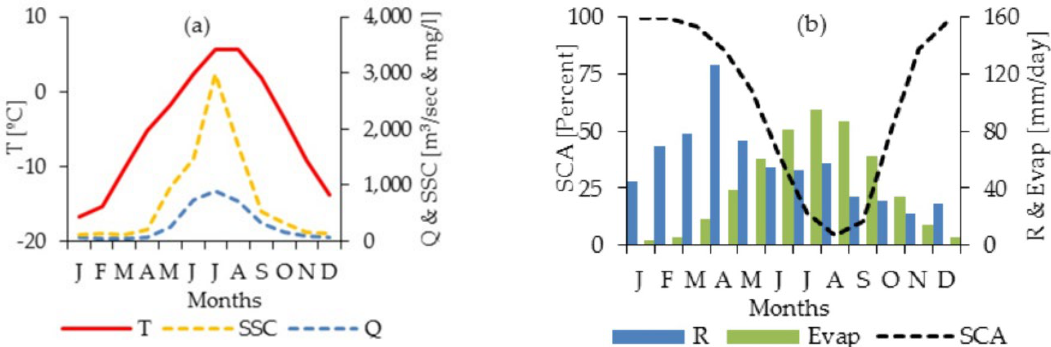
Figure 2. ( a ) Mean temperature (T mean ), discharge (Q) and SSC at the Gilgit gauge; ( b ) snow-covered area (SCA), mean rainfall (R mean ) and mean evapotranspiration (Evap mean ) for the Gilgit Basin during 1981–2010.